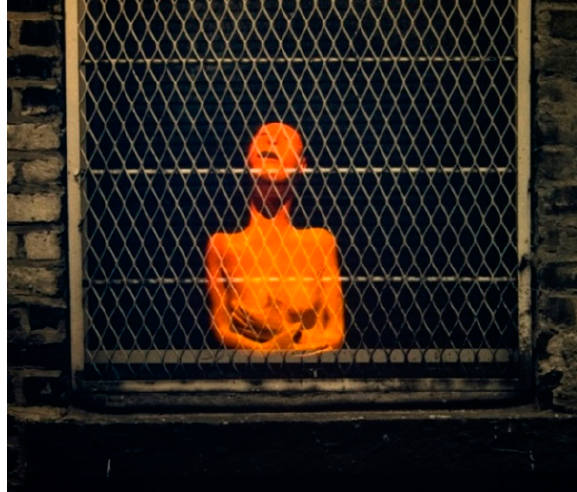
Figure 4. Economy Box (1992), 43 cm × 33 cm × 12 cm.